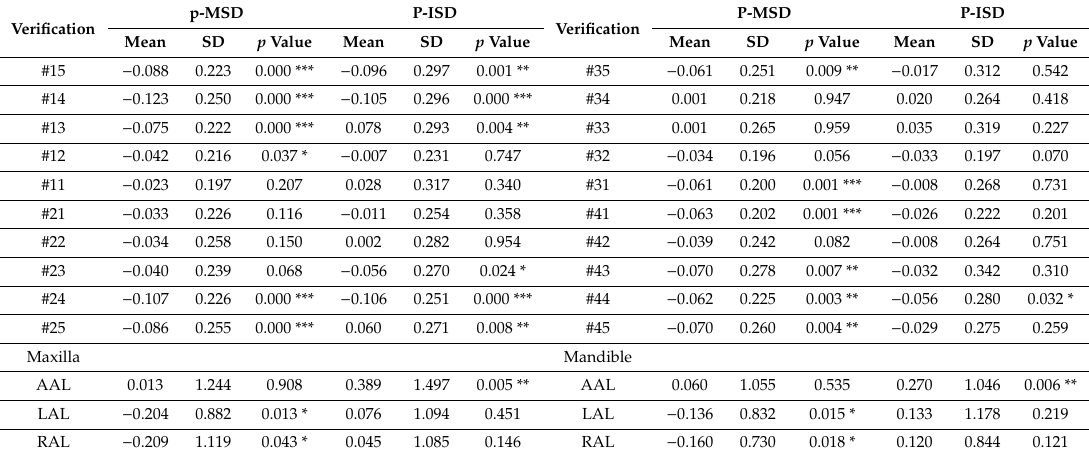
Table 1. Validity of tooth widths and arch lengths measured using each digital